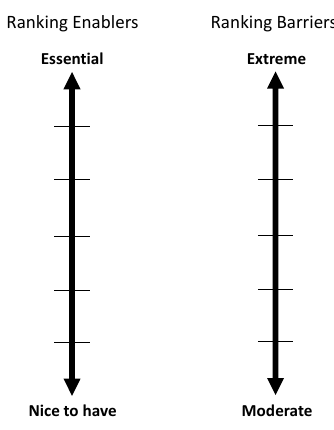
Figure 5. Ranking of enablers and barriers.